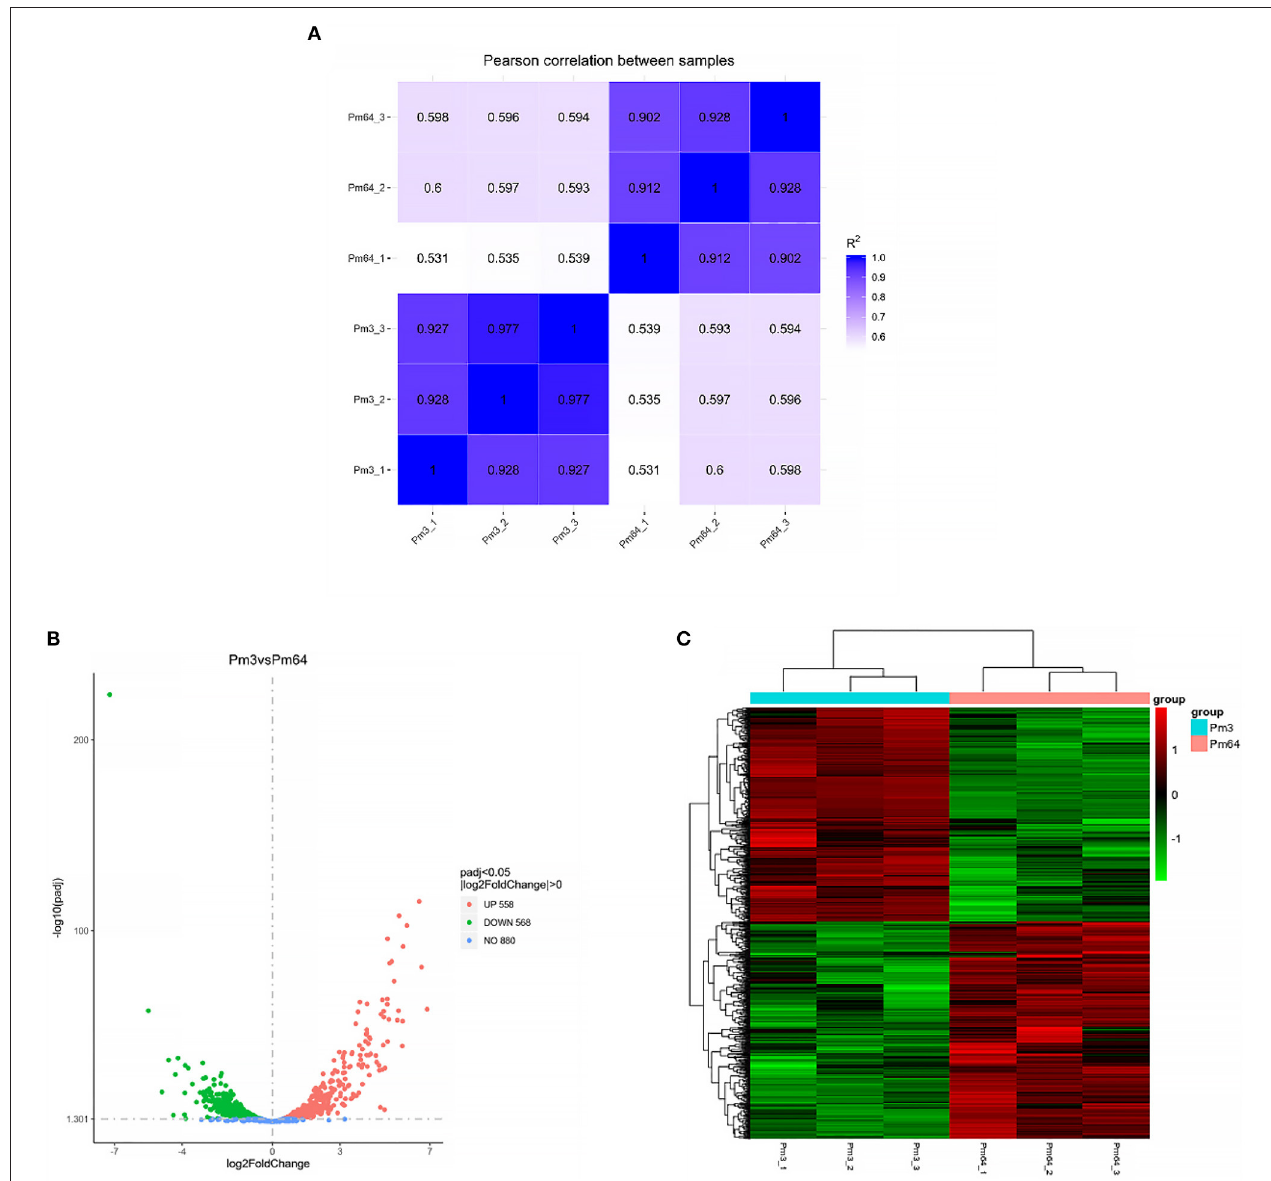
FIGURE 5 | RNA-Seq analysis of Pm3 and Pm64. (A) Correlation map of gene expression. (B) Differential analysis volcano map. (C) The clustering heat map of